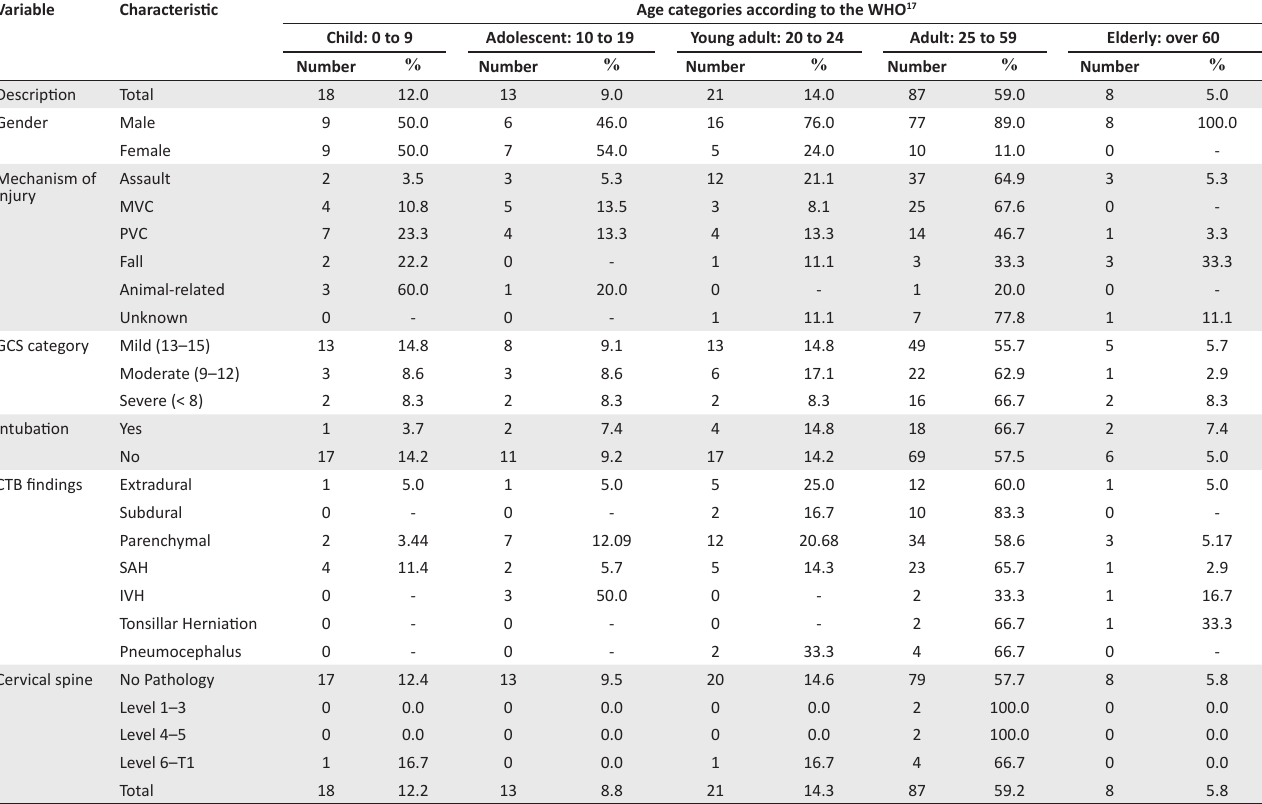
TABLE 1: Patient demographics according to age category ( n = 147).